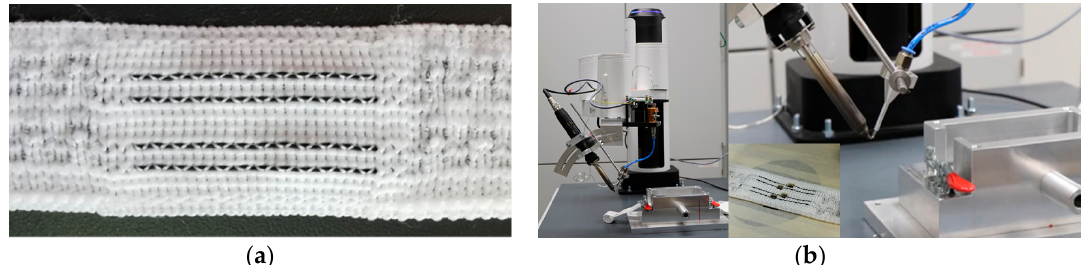
Figure 2. ( a ) Textile tape with flexible and stiff sections. The ribbon is 26 mm width and the position of the wires is axially symmetrical to the centreline. The outer wires have a distance of 12 mm and the inner wires a distance of 6 mm; ( b ) Pictures from the experimental setup, with the four-axis robot and the ultrasonic solder iron and the textile tape after CO 2 —Laser processing.